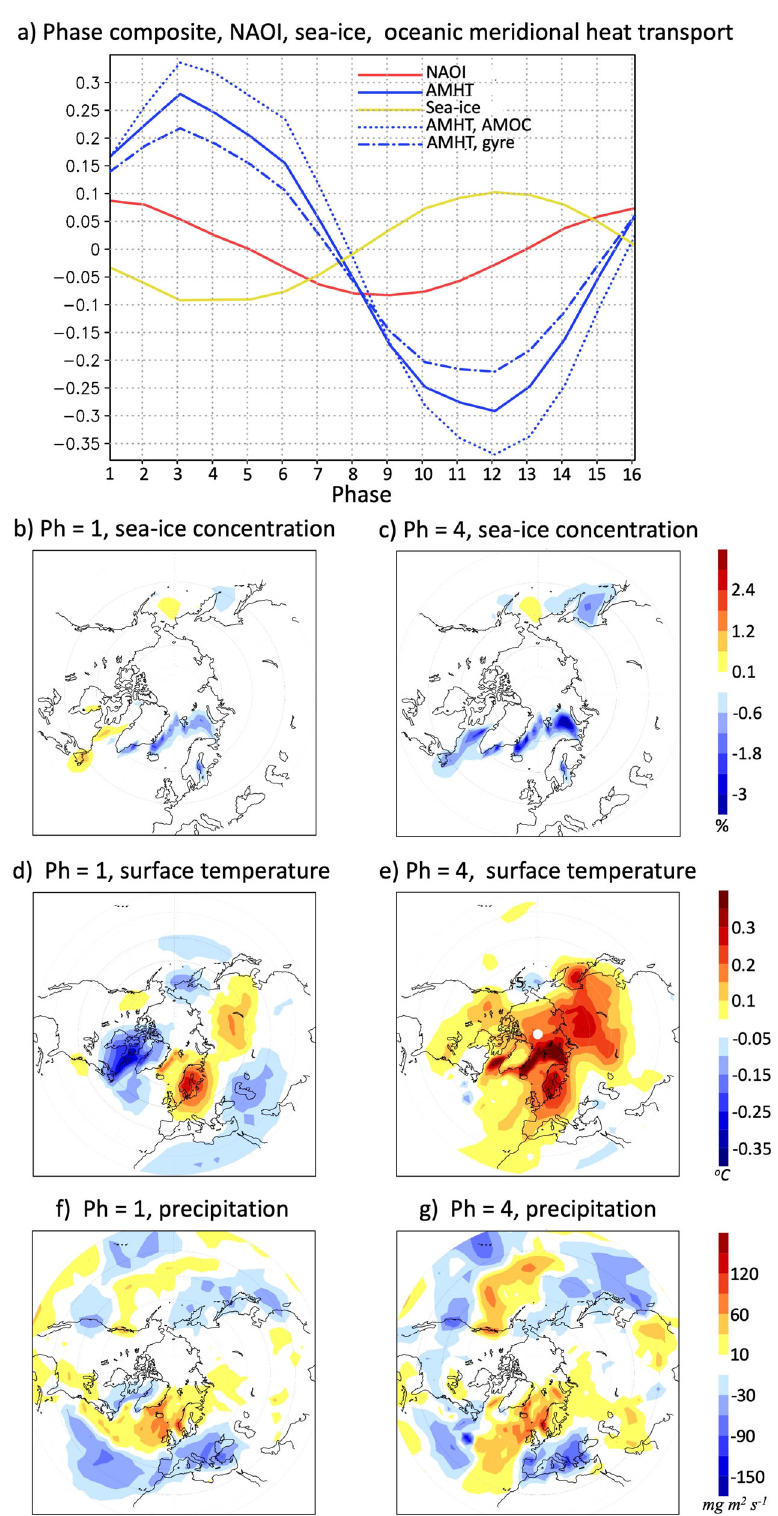
Fig. 6 Impact of the coupled multidecadal stratosphere/troposphere/ocean oscillation on the sea-ice, surface temperature, and precipitation. a The standardized averaged evolution (using phase-composite) of the reconstructed sea-ice concentration (averaged over 60 W – 50 E and 50 – 90 N, in yellow), reconstructed NAOI (red), poleward oceanic heat transport in the Atlantic basin (averaged between 55 N and 75 N, in solid blue), associated contribution from the overturning circulation (blue dotted) and gyre (blue dot dashed). b , c The sea-ice concentration (in %) in b at phase 1 (with positive NAO) and ( c ) phase 4 (with enhanced sea-ice melting), respectively. d , e Surface temperature changes (in °C) in d at phase 1 (associated with positive NAO) and e at phase 4 (associated with enhanced Arctic sea-ice melting). f , g as in d and e , but for the precipitation fl ux (in mg m 2 s − 1